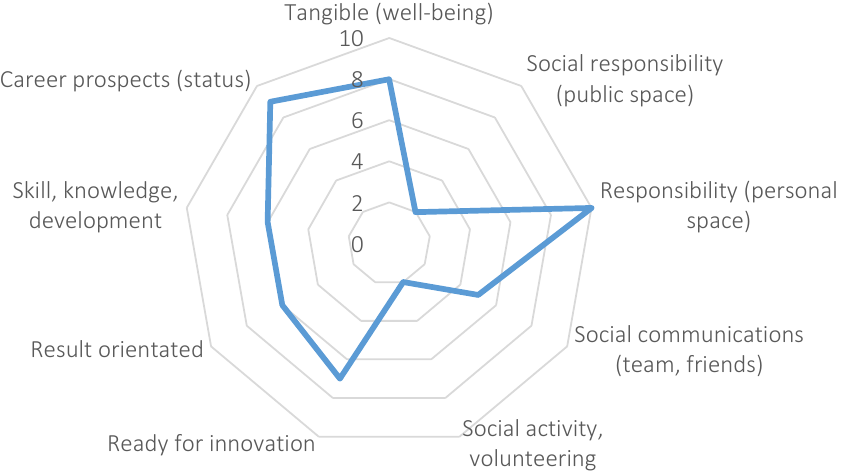
Figure 4. The motivational profile of Generation Z and